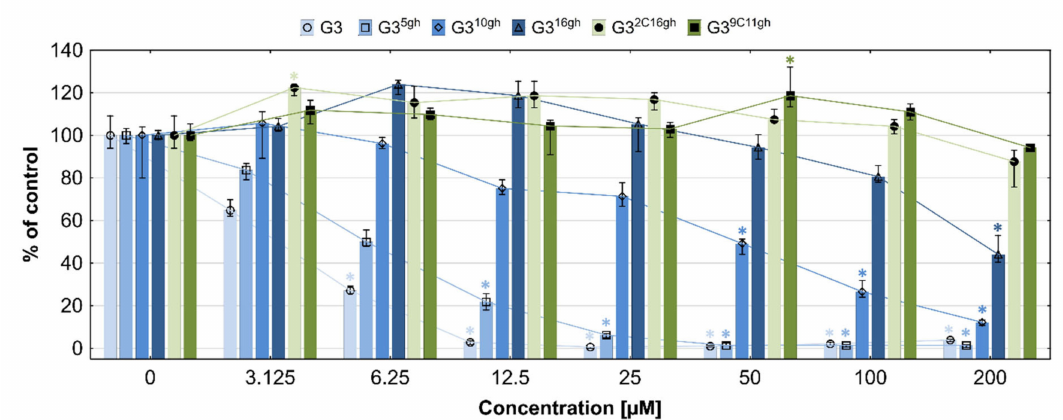
Figure 10. The cytotoxic e ff ect of studied compounds on BJ cells after 24 h incubation, estimated with neutral red assay: Results present as medians of the percent of control taken as 100%. Whiskers mean upper (third) and lower (first) quartile ranges. Statistically significant di ff erences in relation to non-treated control are marked with *, p <